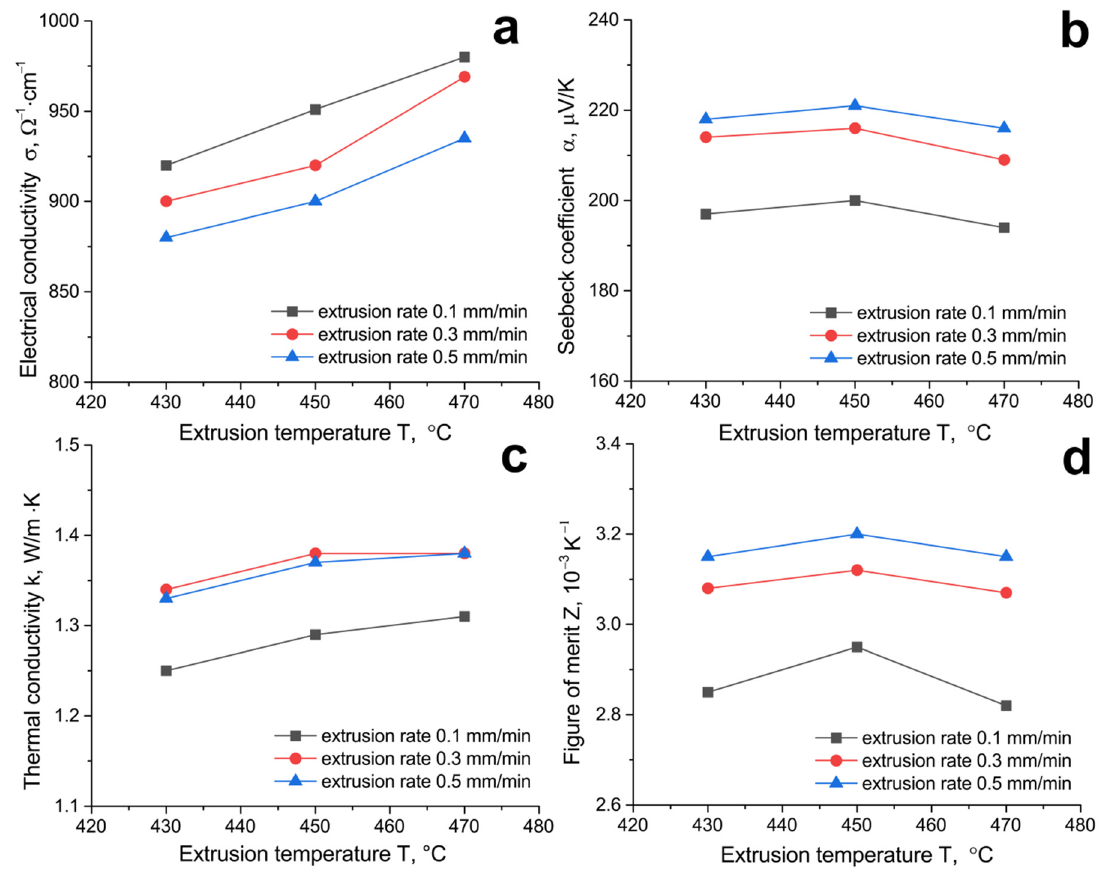
Figure 10. ( а ) Electrical conductivity, ( b ) Seebeck coefficient, ( c ) thermal conductivity, and ( d ) figure of merit as a function of extrusion temperature.